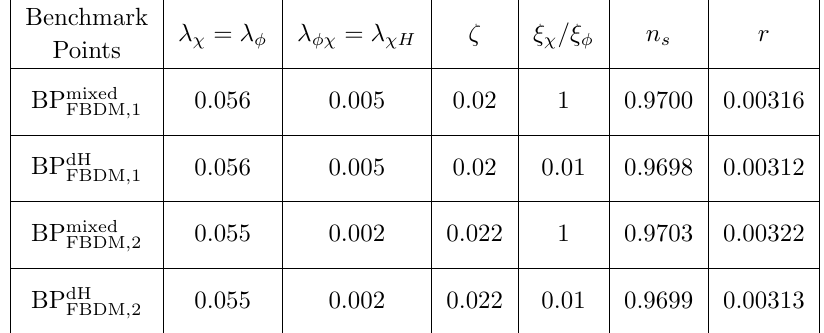
(BP dH ) is the benchmark FBDM ; 1 FBDM ; 1